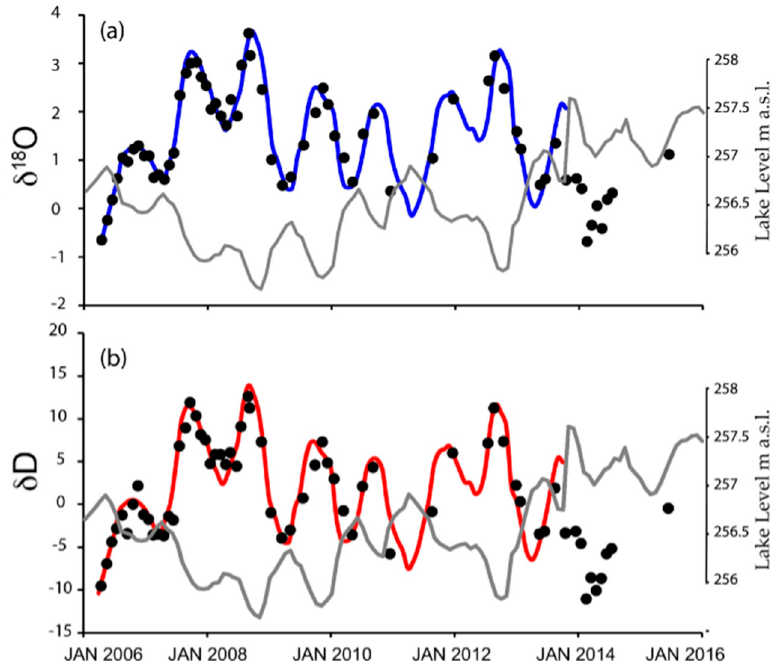
Figure 8. Variations of δ 18 O ( a ) and δ D ( b ) in lake water from 2006 to 2015. Data in permil relative to VSMOW. Black dots refer to the analytical data while blue ( δ 18 O) and red ( δ D) solid lines represent the theoretical values. The theoretical values are presented only up to October 2013 because after this date the hydrologic data are incomplete, making it impossible to apply the isotopic mass balance. In both diagrams are also shown the lake level variations (grey line).